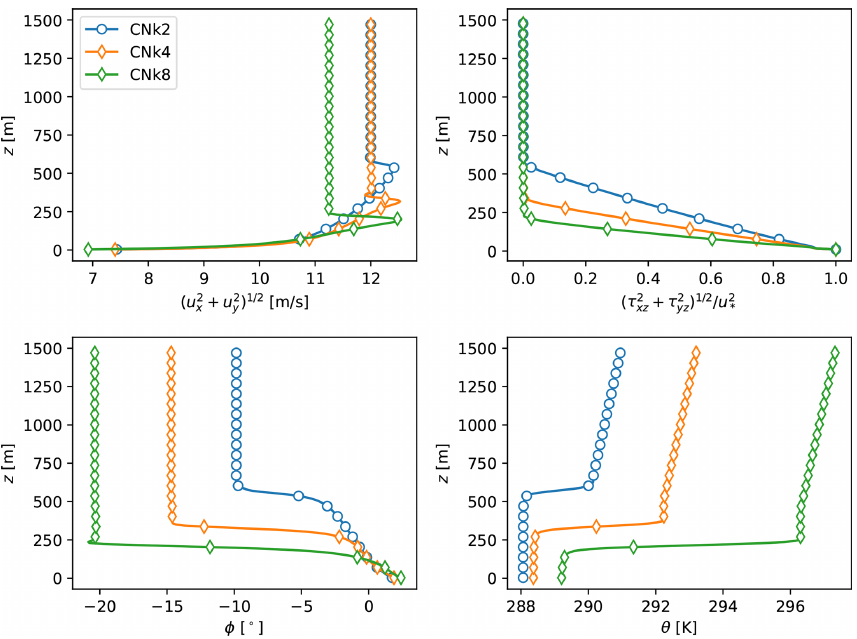
Figure 7. Flow profiles for CNBL cases. Top left: horizontal velocity. Top right: total (resolved + subgrid) shear stress. Bottom left: wind veer. Bottom right: potential temperature. Markers are plotted every 10 data points for clarity. Figure taken from Sood et al.